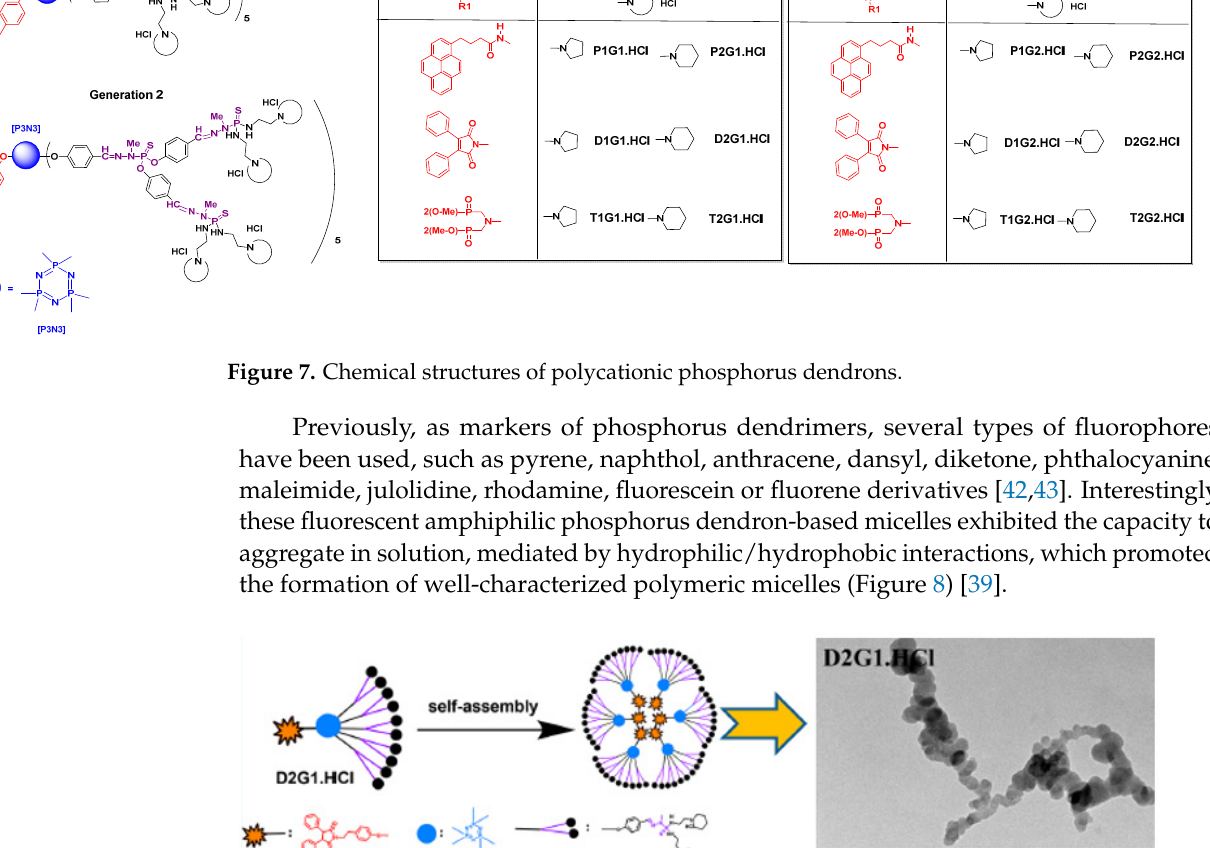
Figure 6. General view of the cell death pathway of phosphorus dendrons in comparison with the corresponding dendrimers.